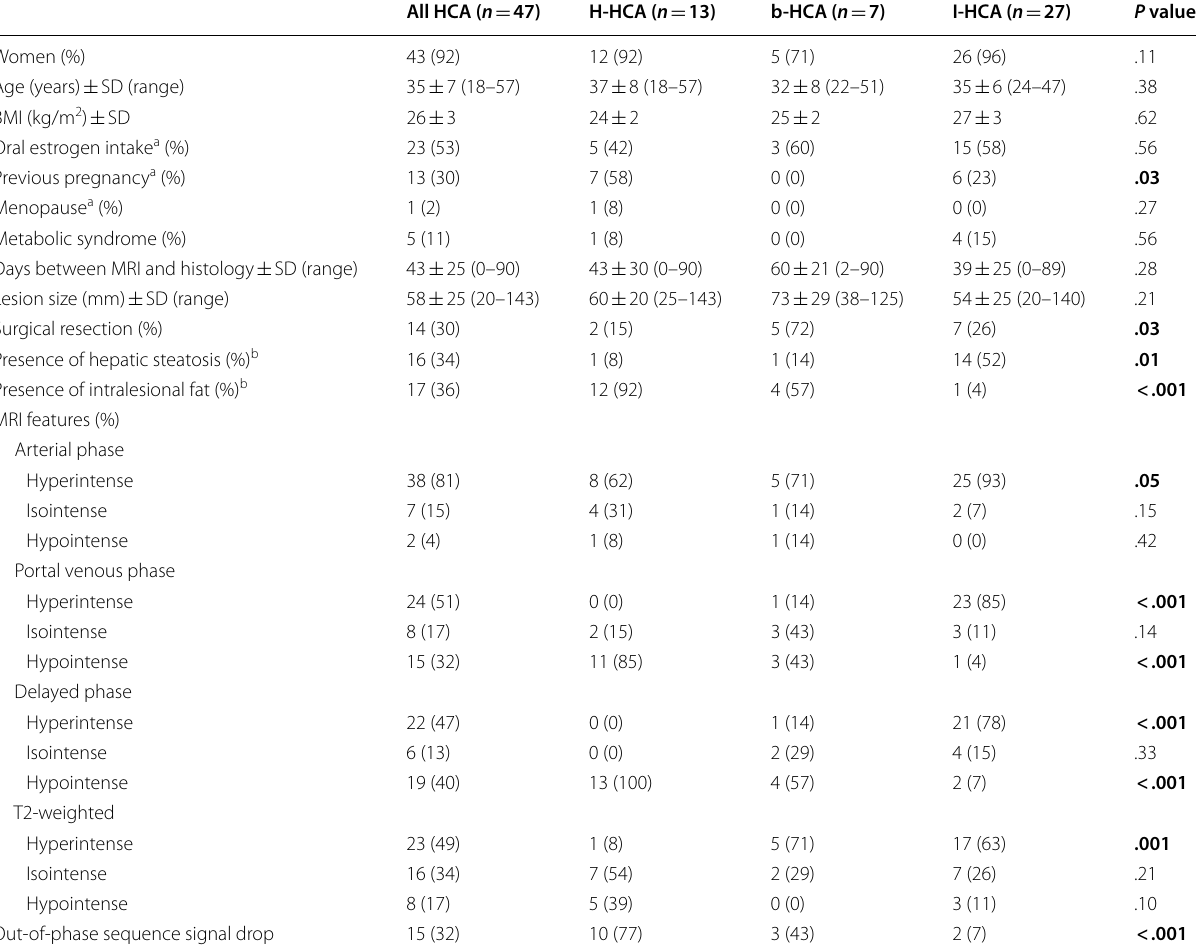
Table 2 Characteristics of hepatocellular adenoma (HCA)